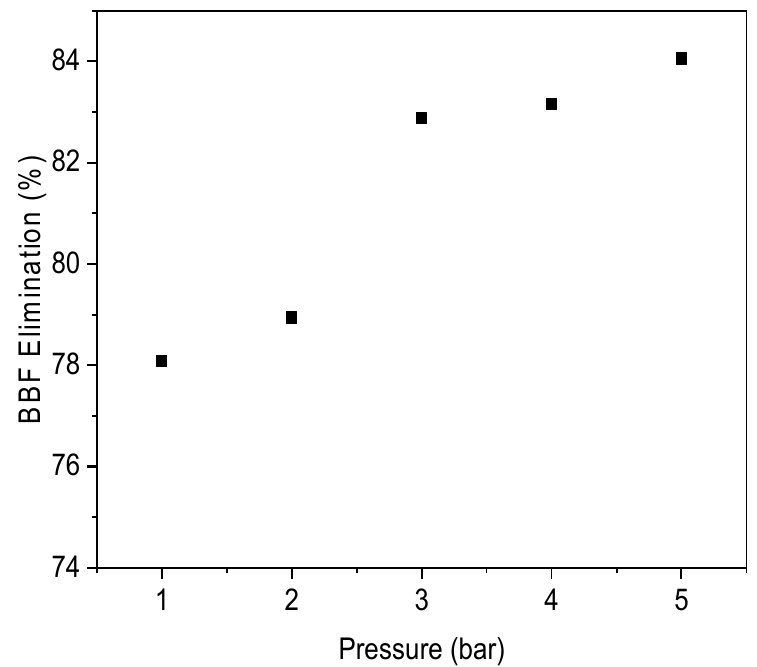
Figure 6. Evaluation of the effect of pressure on COD reduction in industrial discharges: pH wastewater = 5; pH BBF doped wastewater = 7; [COD] wastewater = 205 mg O 2 /L; [BBF] = 40 mg/L; [COD] doped wastewater = 245 mg O 2 /L; Turbidity wastewater = 28 FNU; Turbidity BBF doped wastewater = 33 FNU; treatment time = 15 min.